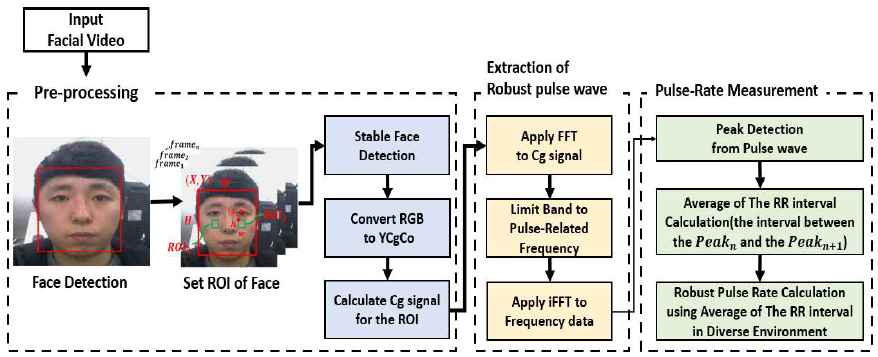
Figure 1. Flowchart of our proposed method.